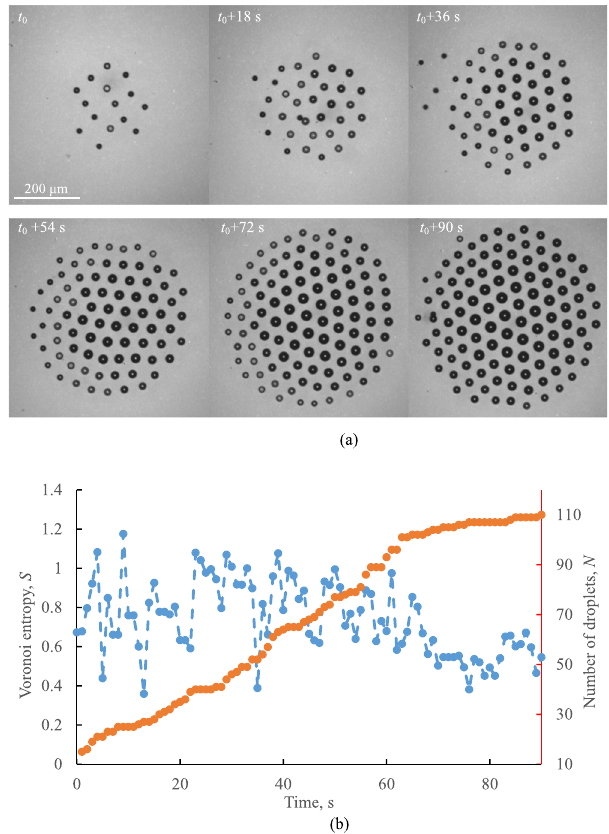
Figure 3. ( a ) Self-assembly of a droplet cluster over a heated water and ( b ) the Voronoi entropy, S (blue), correlated with the number of droplets, N